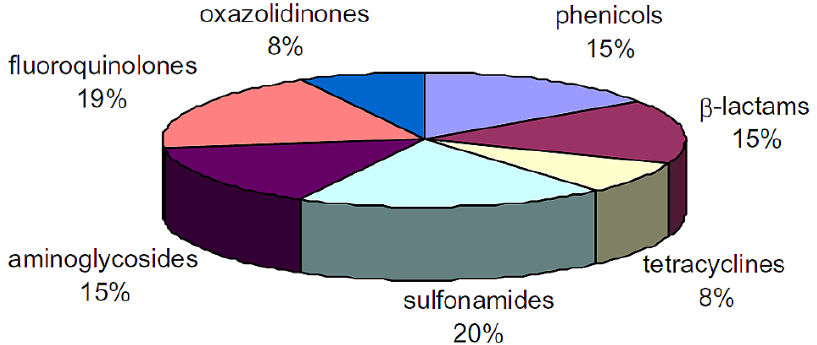
Figure 1. Classification of antibiotic families present in food [7].